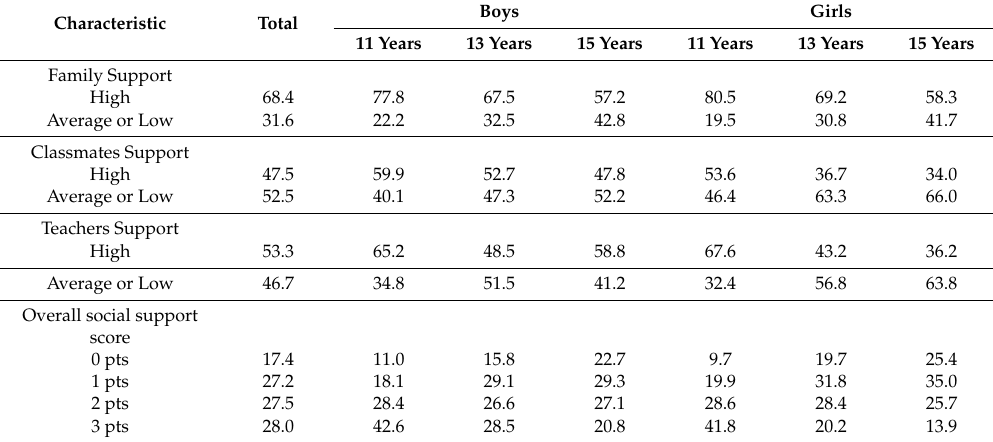
Table 3. Prevalence of perceived social support by age and gender.